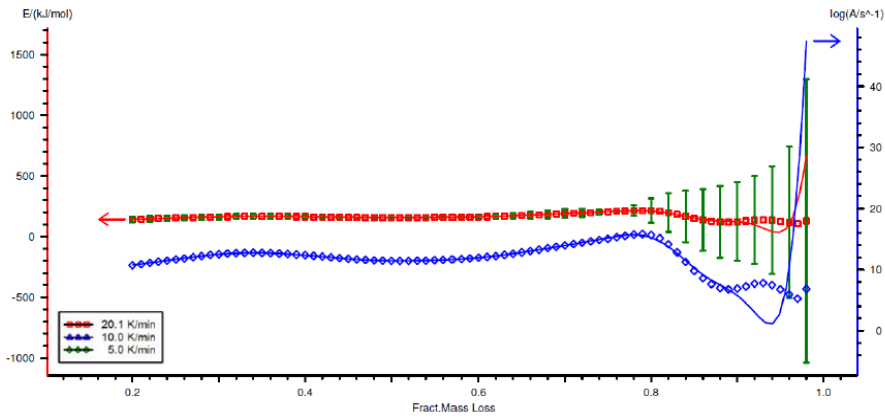
Figure A6. Activation energy and pre-exponential coefficient as a function of the degree of conversion by the Friedman method for a maize straw sample.